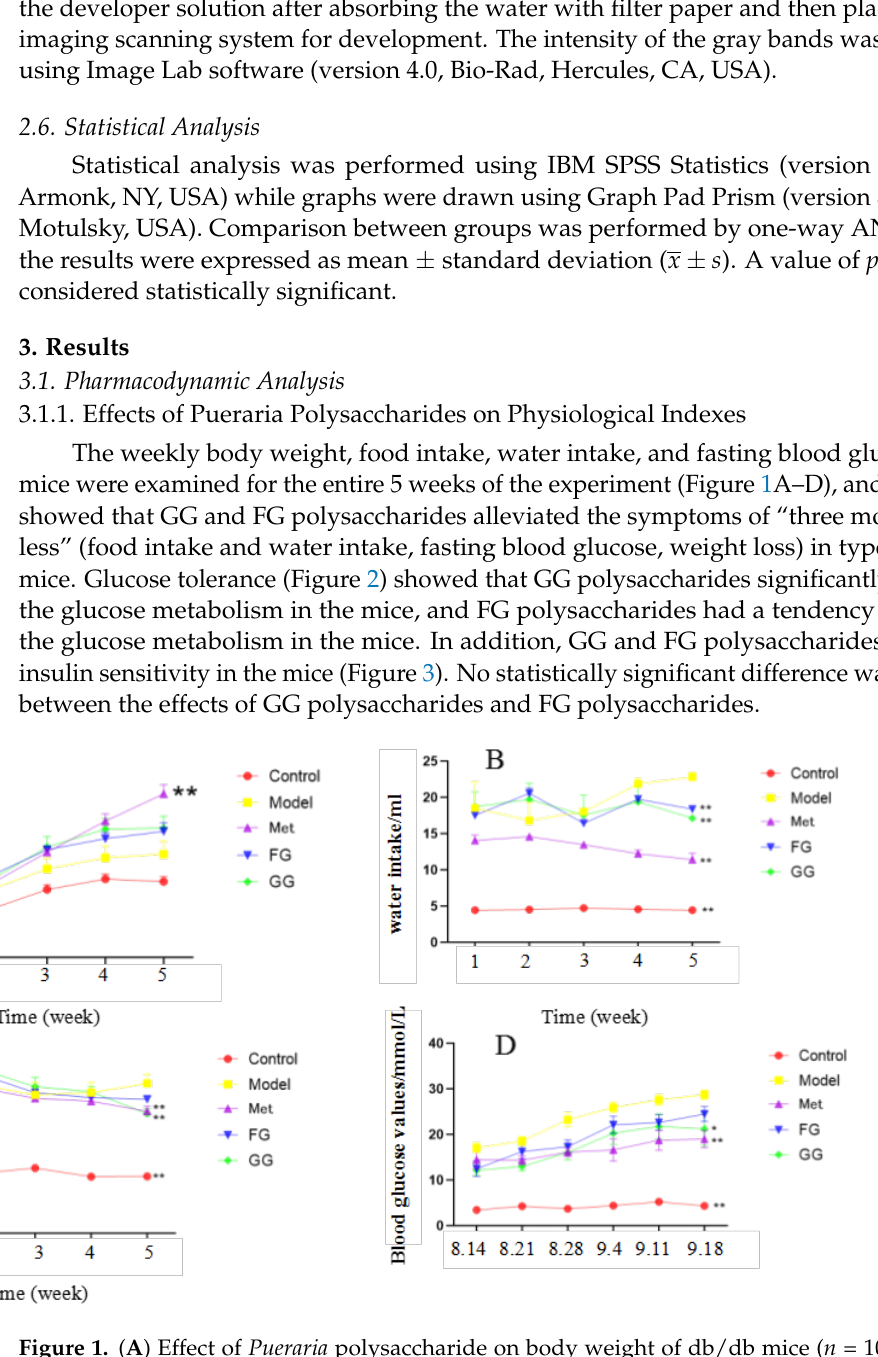
Figure 2. Effects of Pueraria polysaccharide on the glucose tolerance of db/db mice ( n = 10; * p < 0.05; ** p < 0.01 compared with the model group). ( A ) Effect of Pueraria polysaccharide on blood glucose value in db/db mice; ( B ) Effect of Pueraria polysaccharide on AUC in db/db mice.